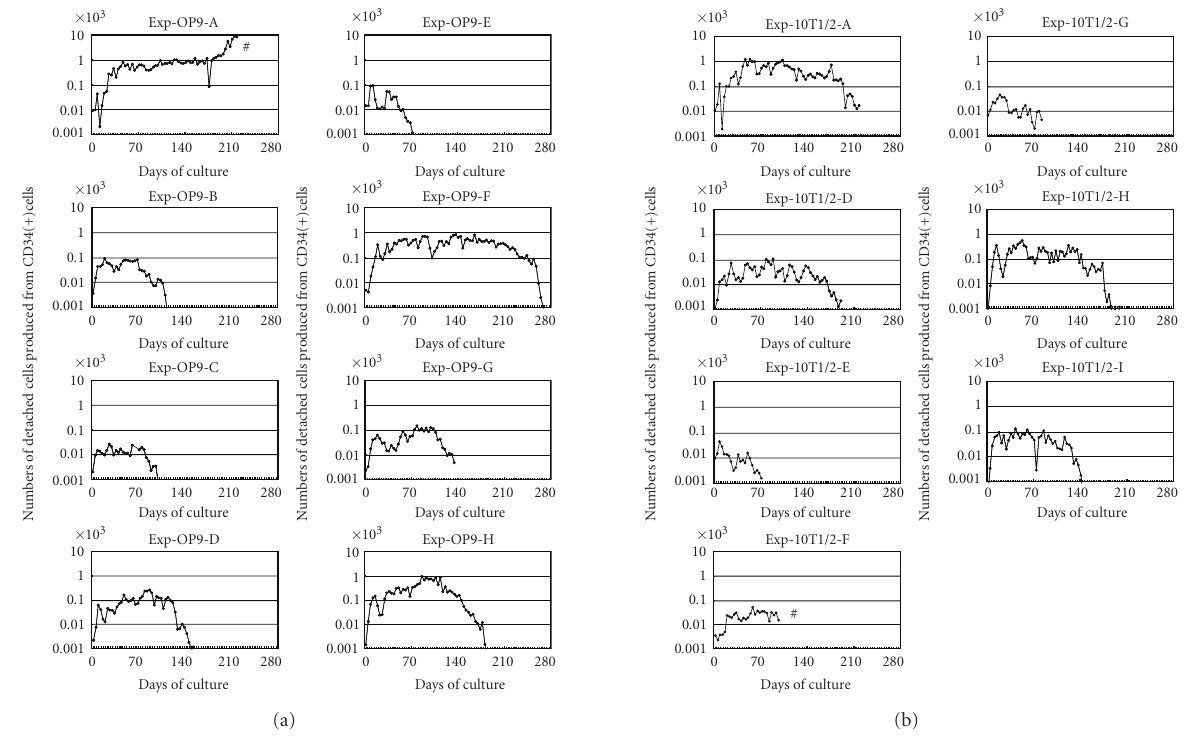
Figure 2: Production of hematopoietic cells in long-term cultures of human hematopoietic stem cells. (a) Eight independent experiments were performed using eight di ff erent umbilical cord blood samples and OP9 cells as feeder cells. (b) Seven independent experiments were performed using seven di ff erent umbilical cord blood samples and C3H10T1/2 cells as feeder cells. ((a), (b)) The number of detached cells in the overlying medium was counted at each medium change (approximately half weekly). The data are shown as the mean number of detached cells produced from a single CD34(+) cell, that is, the total number of detached cells divided by the number of CD34(+) cells used to initiate the culture. Exp: experiment. A to I after Exp-OP9 and Exp-10T1/2 indicate 9 di ff erent umbilical cord blood samples derived